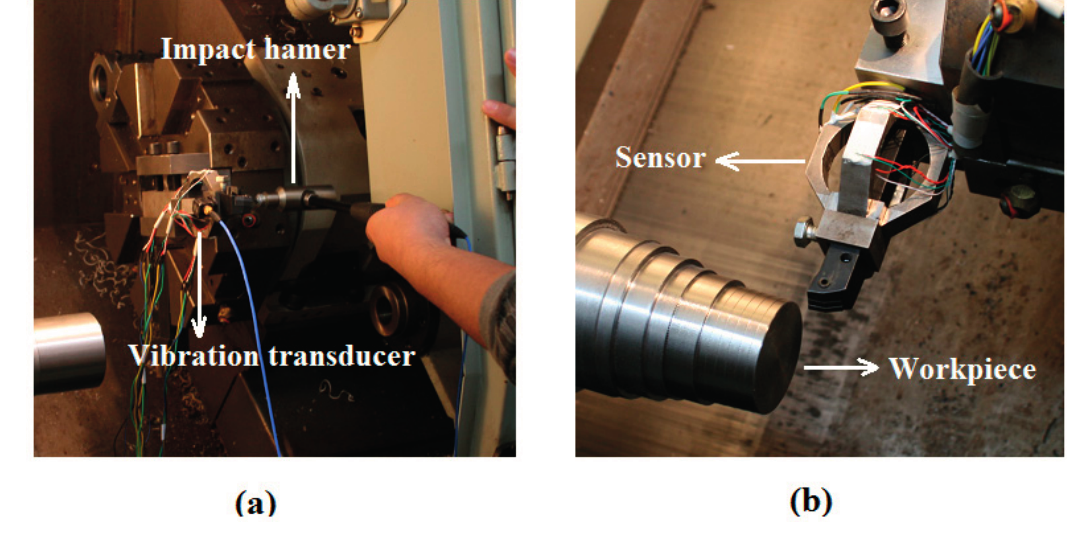
Figure 7. Experimental setup for: ( a ) impacting modal test and ( b ) dynamic cutting